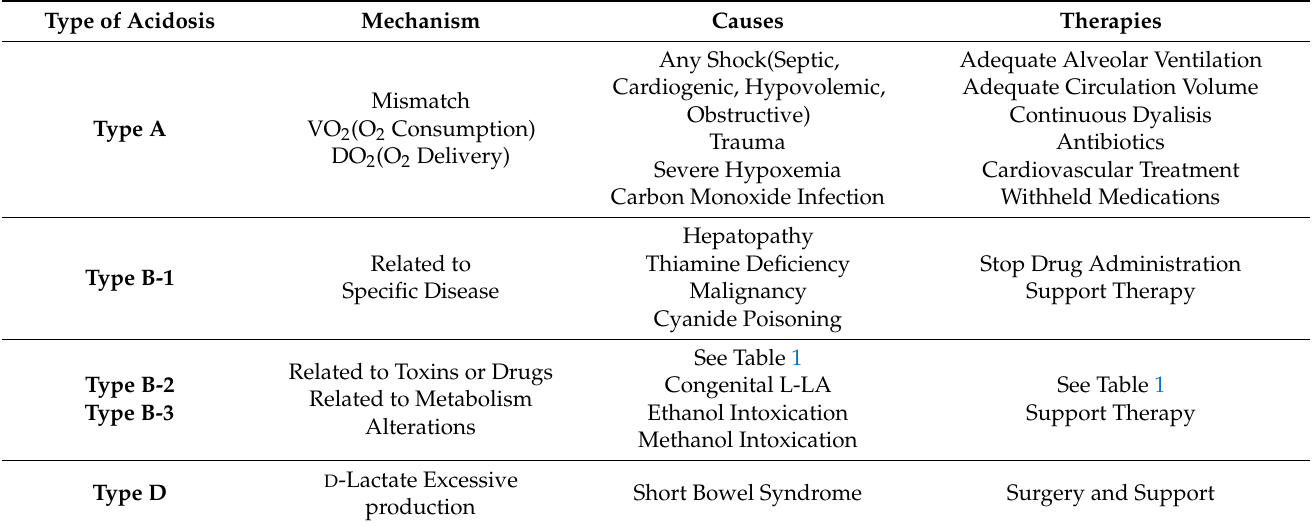
Table 2. Types of